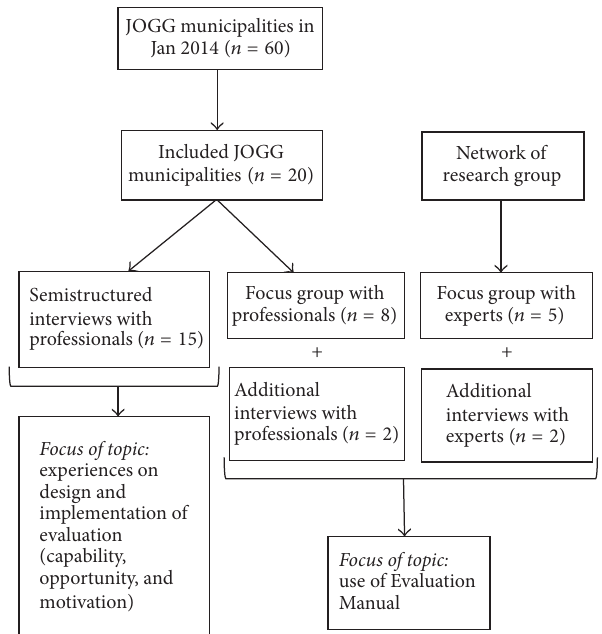
Figure 1: Graphic of study